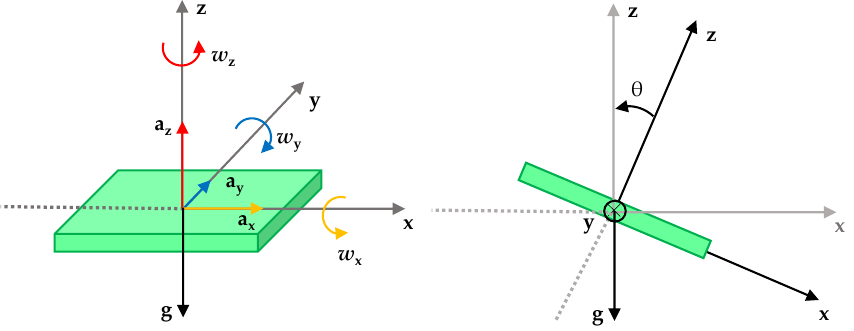
Figure 2. Geometric relation between tilt angles and acceleration referred to z-direction for a device installed on the top of a